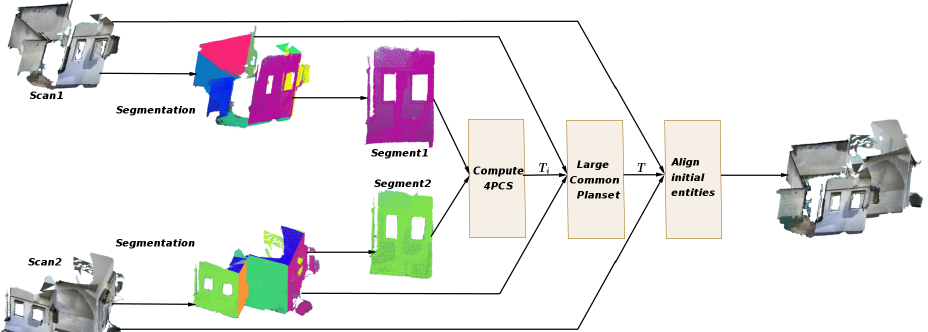
Figure 4. LCP-4PCS: let two point clouds Scan 1 and Scan 2 be two partial or complete overlapping scans of the same object. To align Scan 1 to Scan 2, LCP-4PCS proceeds as follows: segments Scan 1 and Scan 2 into planes; applies iteratively 4PCS to individually align Scan 1 segments to Scan 2 segments; at each iteration, uses the transformation T i from 4PCS process to find a set corresponding segments by applying T i to Scan 1 segments; finally uses the transformation T from the previous step which builds the largest set of corresponding planes between Scan 1 segments and Scan 2 segments to align Scan 1 and Scan 2 (applies T ( Scan 1 )